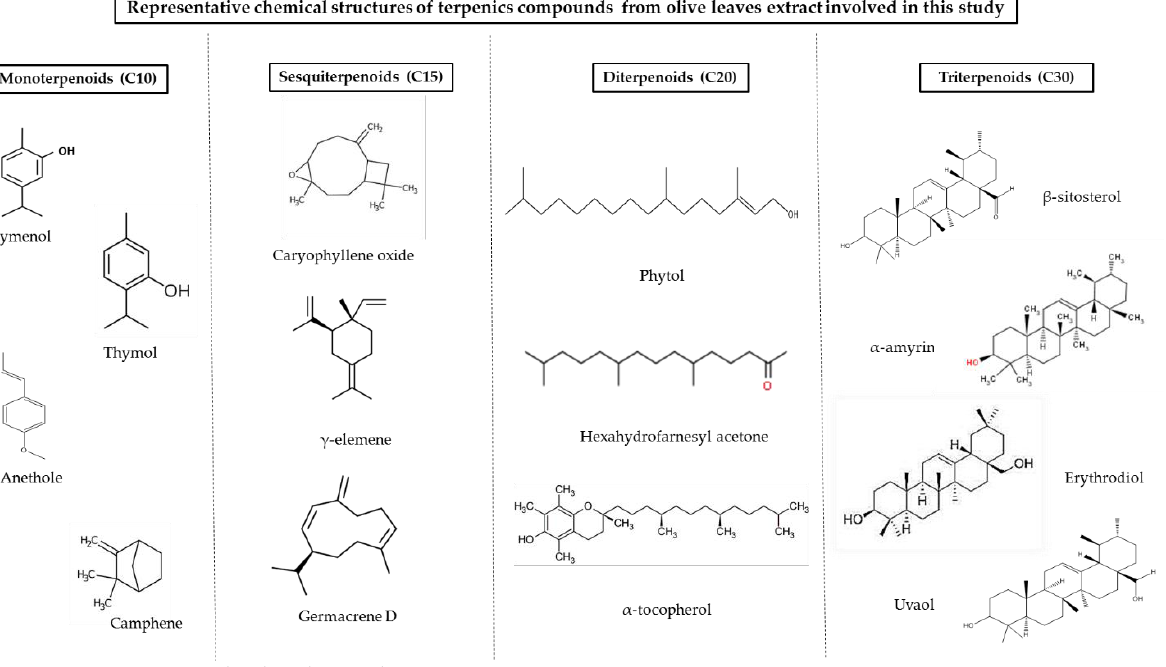
Figure 6. Representative chemical structures of terpenoid compounds from olive leaves extracts involved in this